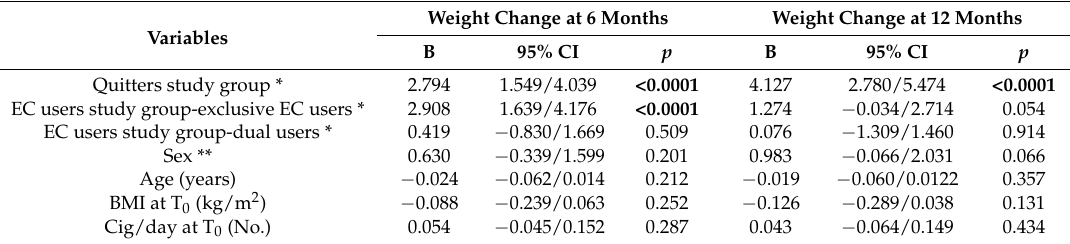
Table 3. Parameters estimated by multiple linear regression analysis models for percent weight change at 6 and 12 months as dependent variable and group, sex, age, BMI at baseline, and number of cigarettes smoked at baseline as independent variables.